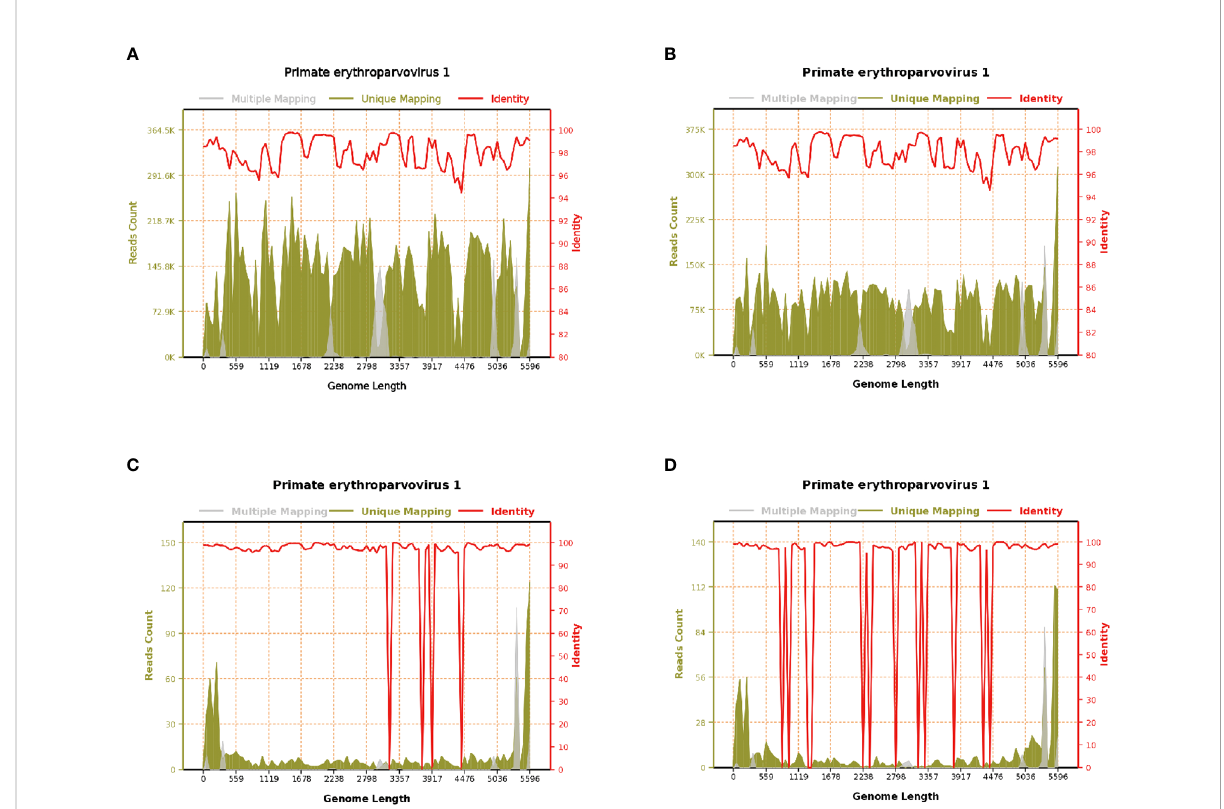
FIGURE 2 Parvovirus B19 genome coverage of case 1. (A) Blood on August 19, 2020; reads count: 13,953,069, genome coverage: 100% (5596/5596). (B) Blood on August 22, 2020; reads count: 9,006,108, genome coverage: 100% (5596/5596). (C) Blood on August 31, 2020; reads count: 955, genome coverage: 98.427448% (5508/5596). (D) Cerebrospinal fl uid on August 28, 2020; reads count: 832, genome coverage: 91.976412%